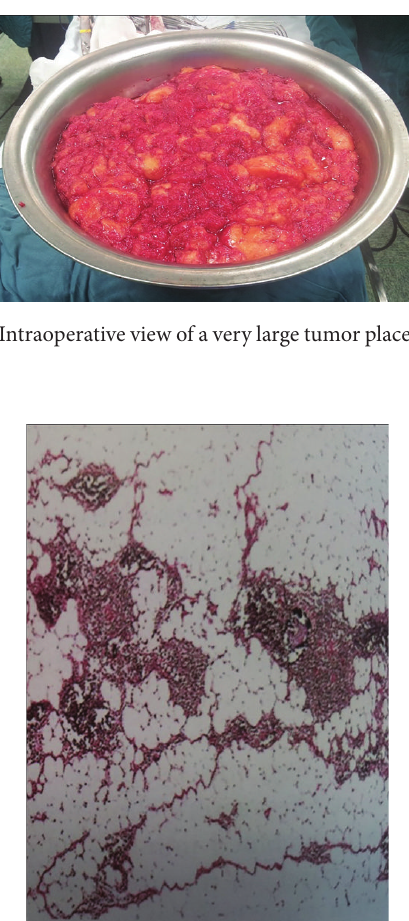
Figure 4: Histologic appearance of thymolipoma showing